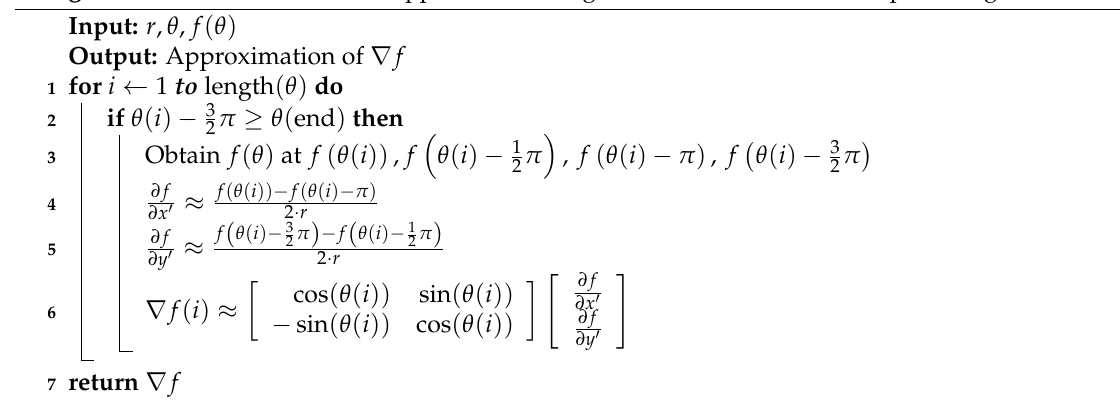
Algorithm 1 C IRCLE G RADIENT approximates the gradient of a scalar from samples along an